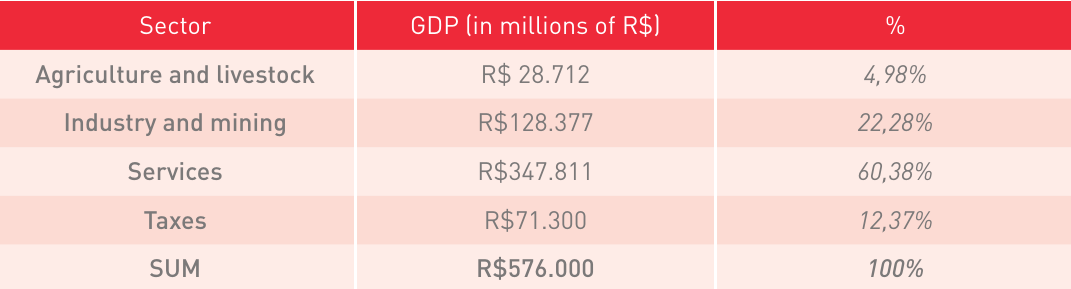
Minas Gerais’ Gross Domestic Product by sectors in 2017 Sector GDP (in millions of R$) % Agriculture and livestock R$ 28.712 4,98% Industry and mining R$128.377 22,28% Services R$347.811 60,38% Taxes R$71.300 12,37% SUM R$576.000